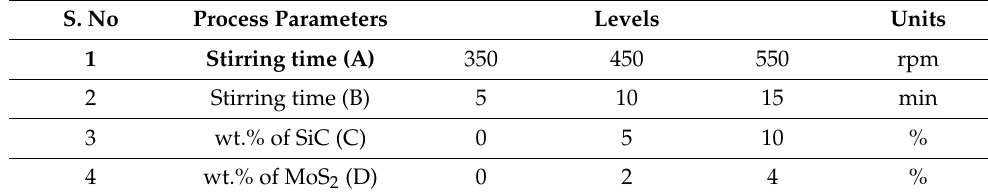
Table 3. Experimental parameters and their levels.